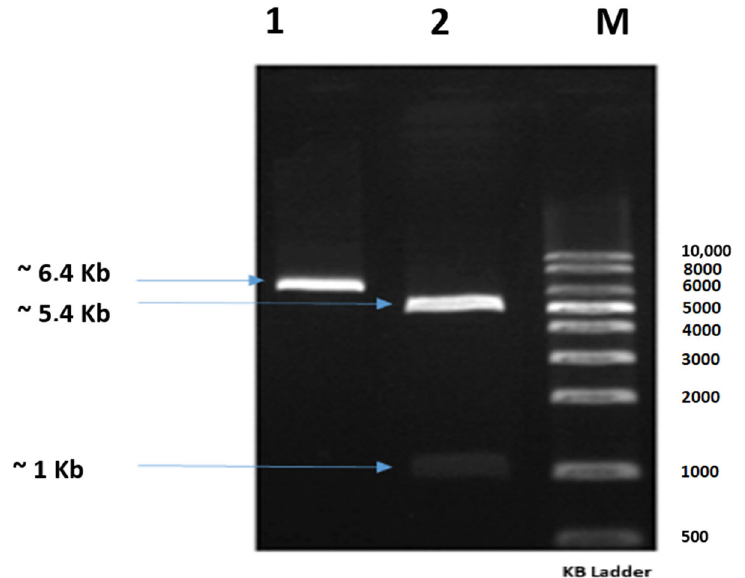
Figure 1. Agarose gel showing the construct pET ‐ 30a/ps2Aa1 treated with the restriction enzymes Kpn I and Hind III; Lane 1: construct pET ‐ 30a/ps2Aa1; Lane 2: construct pET ‐ 30a/ps2Aa1 treated with the restriction enzymes Kpn I and Hind III; Lane M: molecular weight marker.